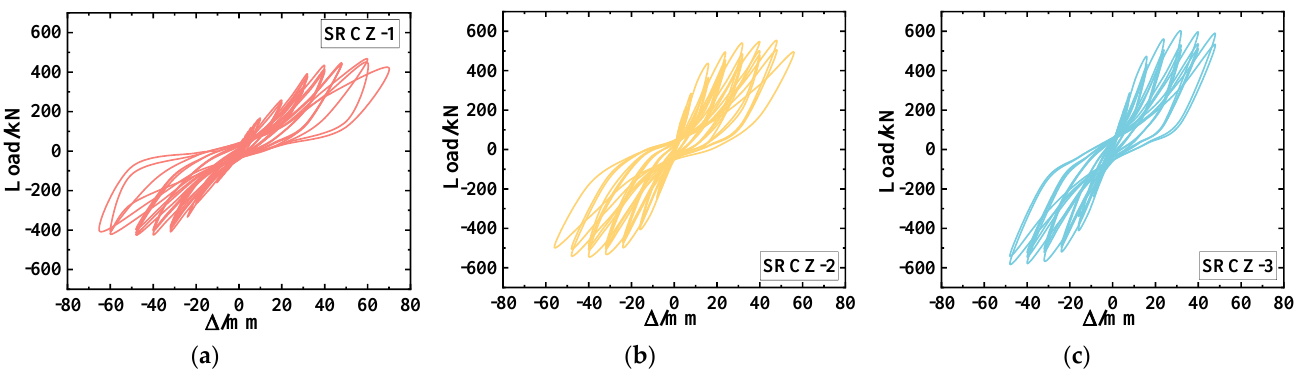
Figure 7. The Hysteresis Loops. ( a ) SRCZ-1. ( b ) SRCZ-2. ( c ) SRCZ-3.